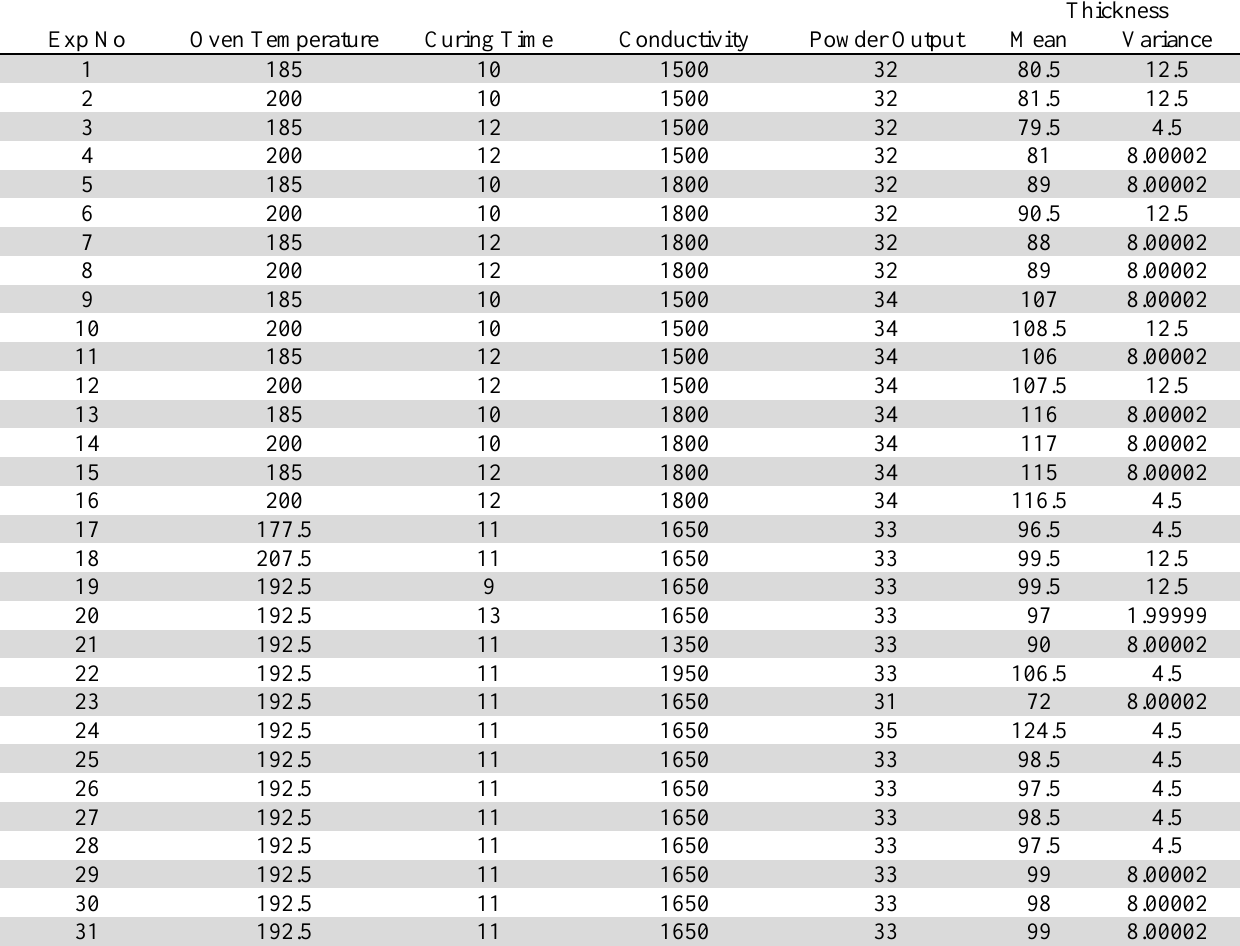
Table 2 Experimental layout with response mean and variance